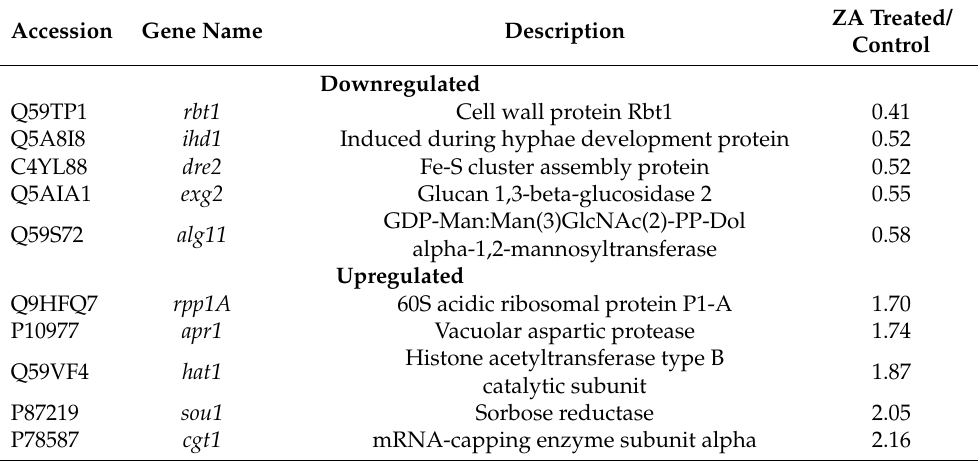
Table 1. Differentially expressed proteins in biofilms upon ZA treatment. Fold changes with respect to the control were calculated by dividing the label-free quantification (LFQ) mean intensity value of the treated samples by that of control